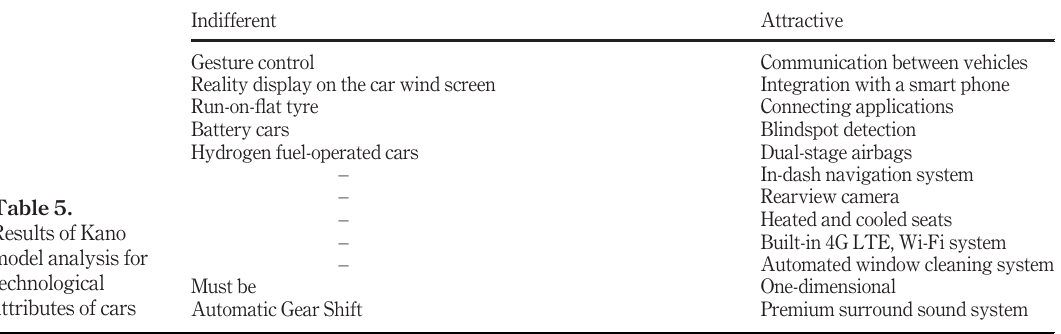
Table 5. Results of Kano model analysis for